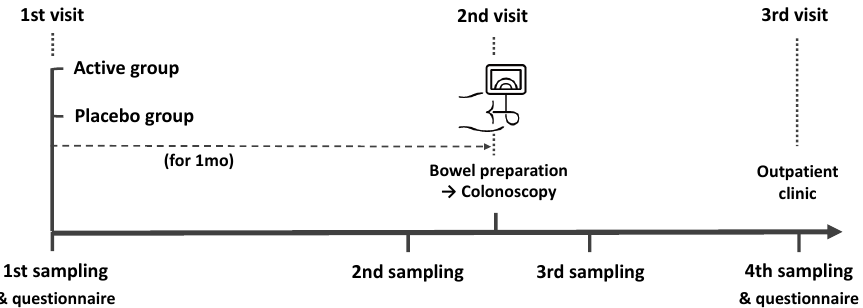
Figure 1. Schematic drawing of the time flow used in this study.